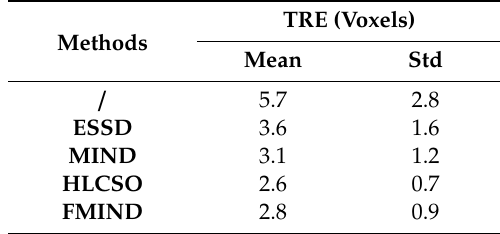
Table 5. TRE for all evaluated methods operating on the 3D CT–PET image pairs.